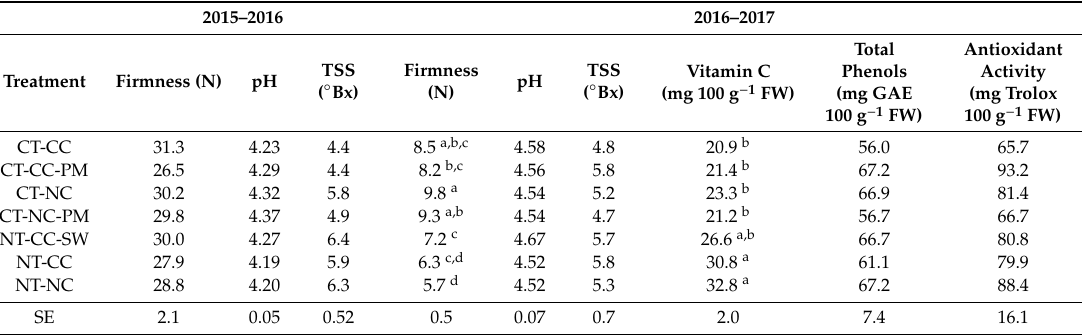
Table 6. Marketable fruit basic and nutraceutical characteristics from each of the systems in